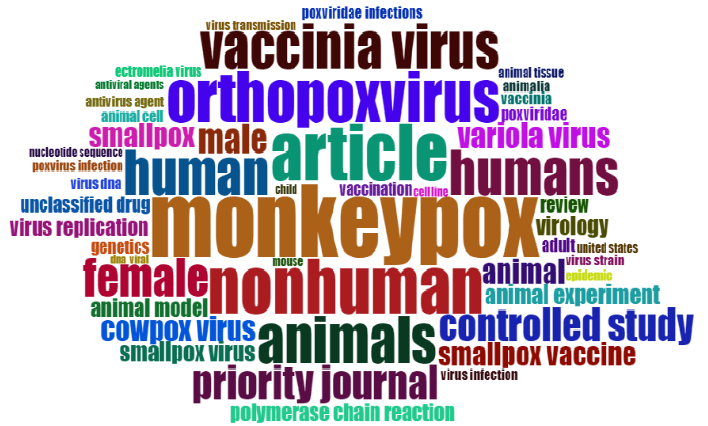
Figure 1. Word cloud of author keywords frequency during 2001–2021 (the size of keywords repre- sents the frequency of occurrence).